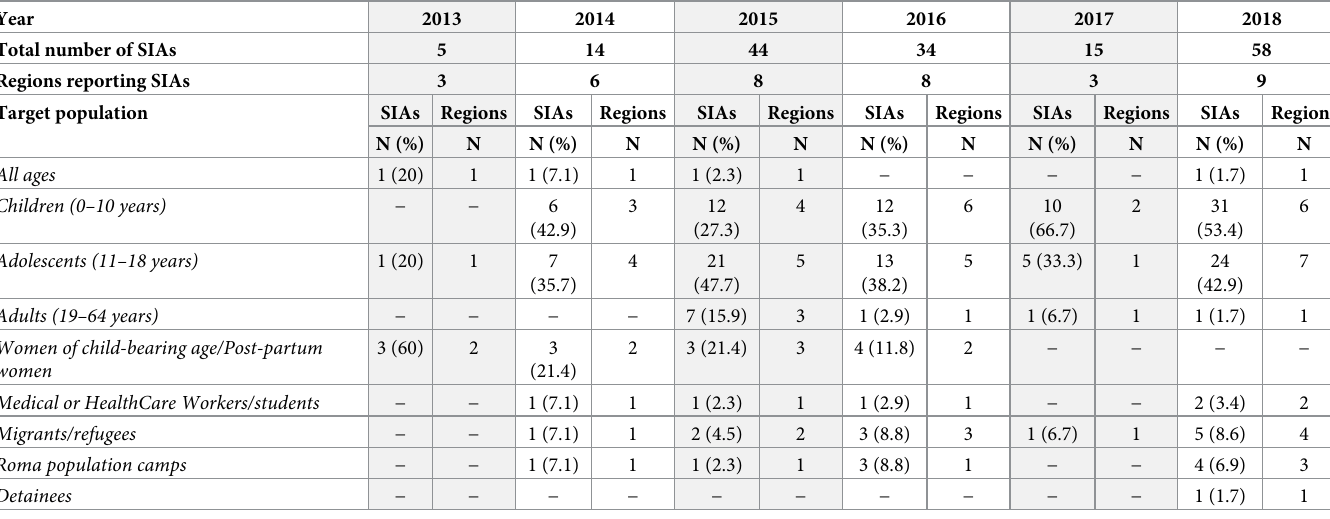
Table 3. Frequency of SIAs and of regions reporting SIAs by target population, Italy,